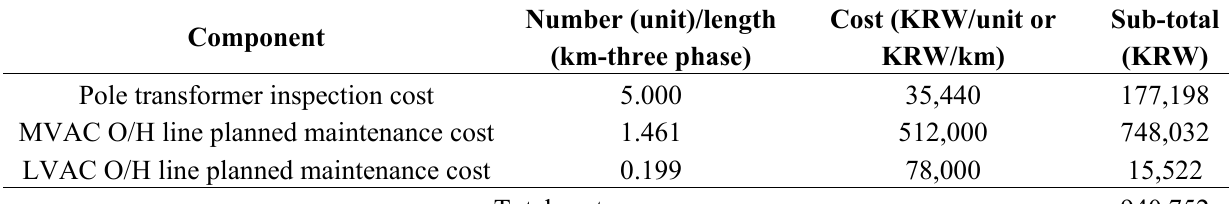
Table 6. Maintenance costs of MVAC.